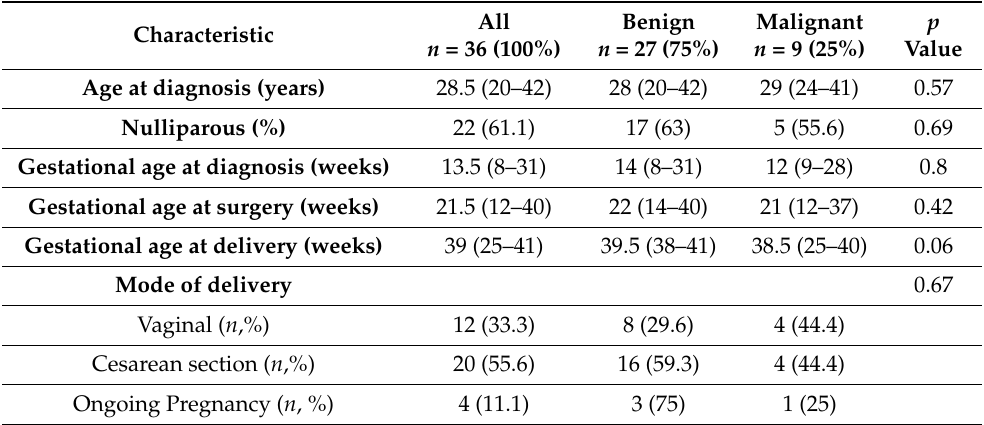
Table 2. Clinical characteristics of the studied